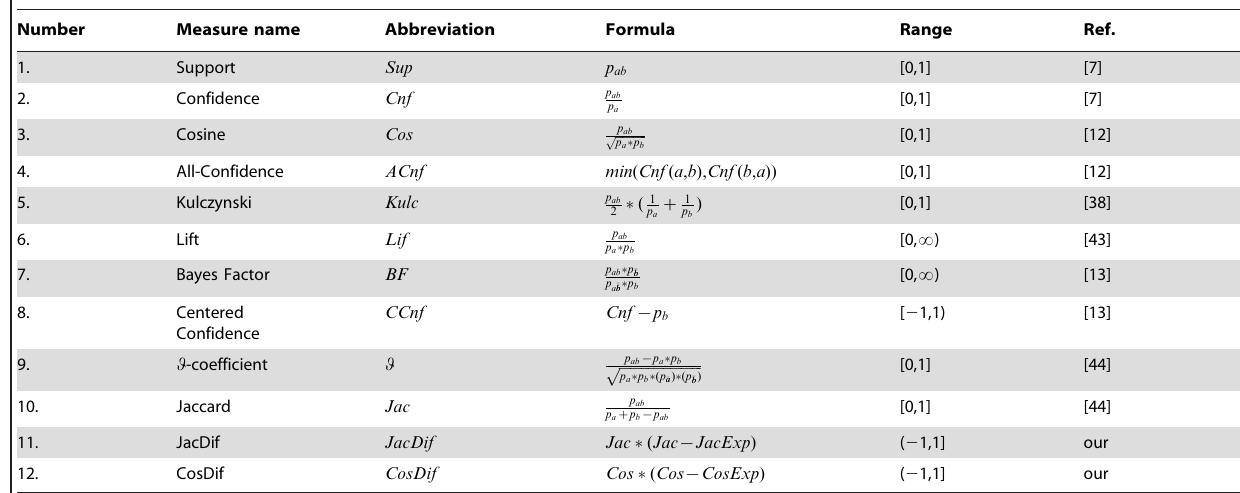
Table 1. Measure List.